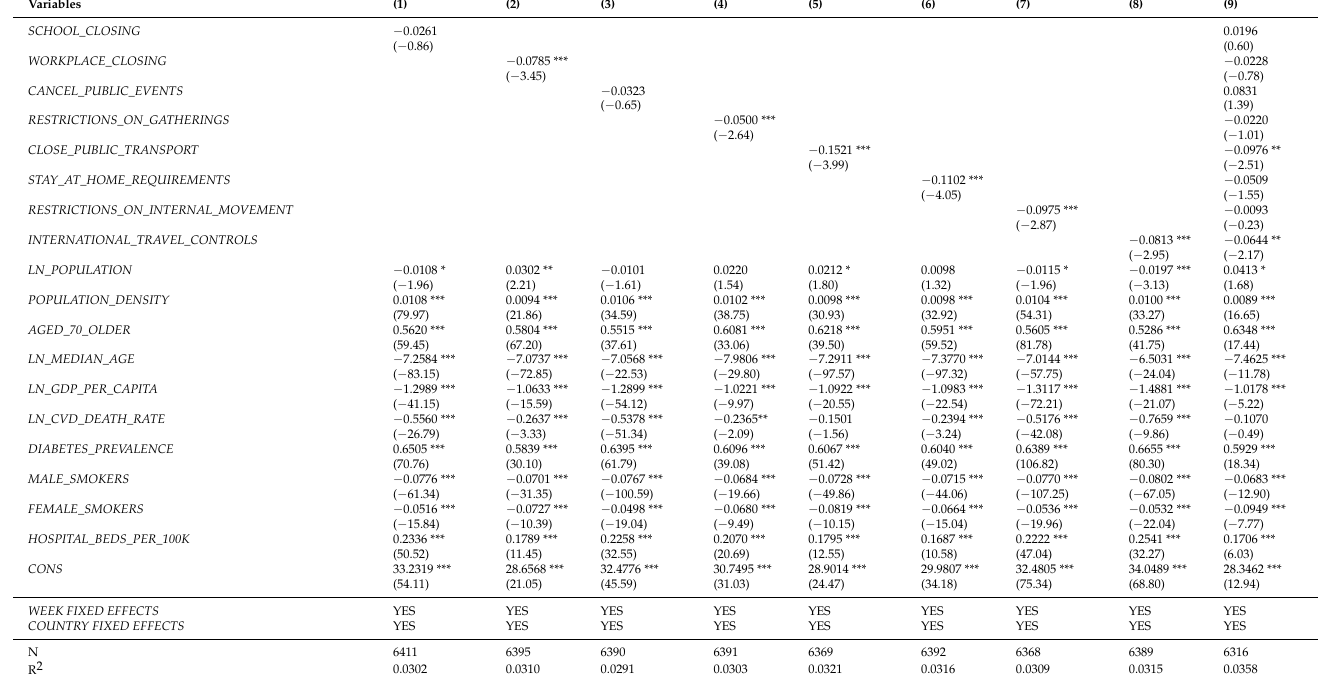
Table 3. Regression analysis of the effect of containment and closure policies on the COVID-19